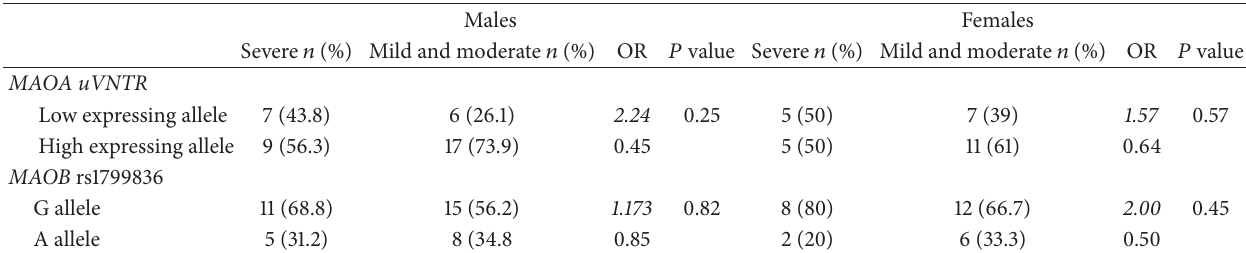
Table 3: Relation between MAOA/B polymorphisms and severity of autistic patients. Males